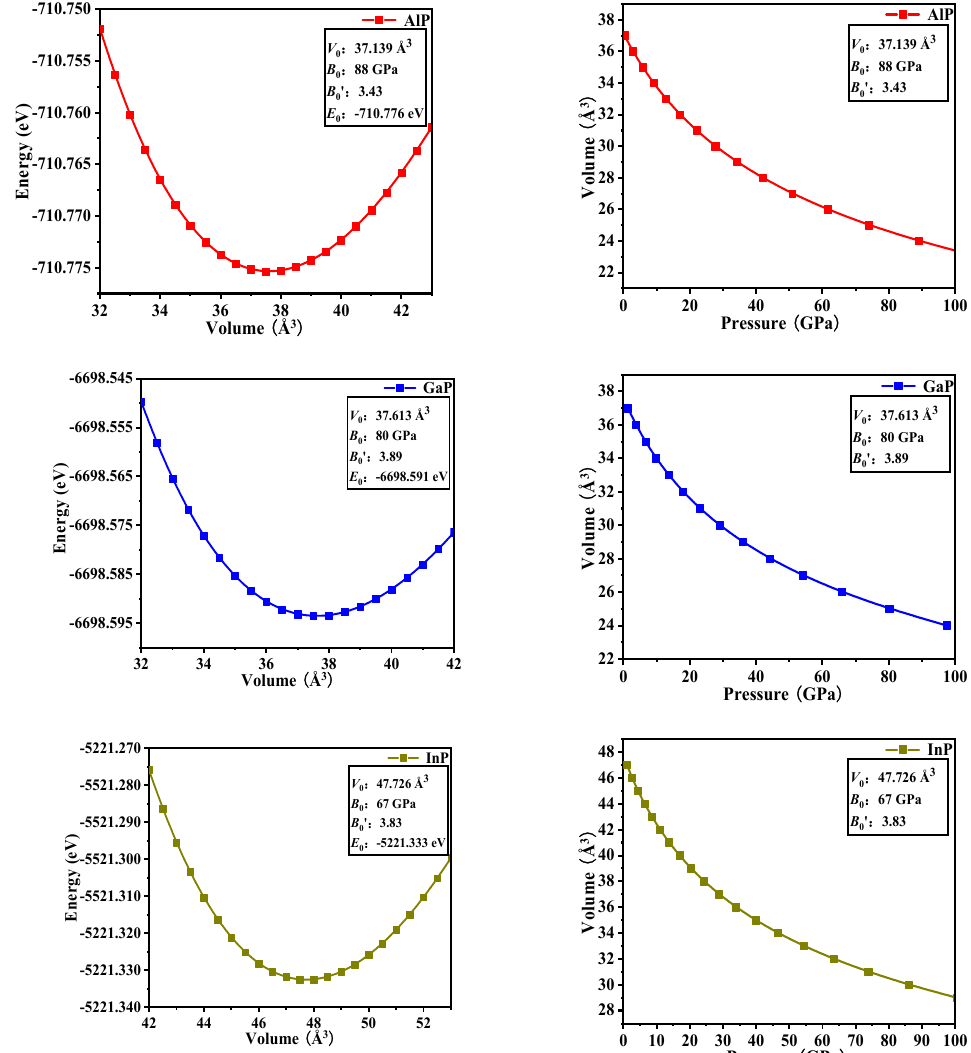
Figure 3. Computed total energy versus unit-cell volume ( left column ) and the variation of the volume versus pressure ( right column ) for P 6 4 22- X P ( X = Al, Ga, or In).